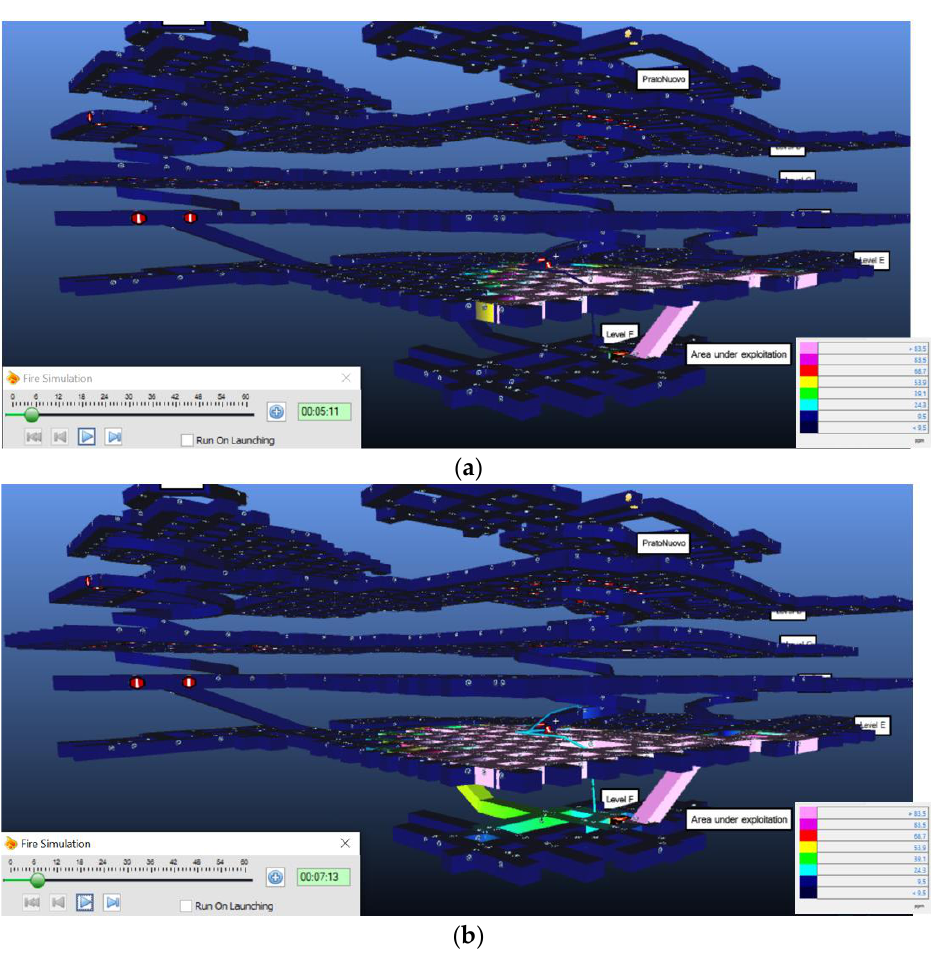
Figure 6. Concentration of carbon monoxide (CO) in ppm in the lower areas of the mine in the presence of a fire of a loader at Level F (Case B1). ( a ) After 5 min from the start of the fire and ( b ) after 7 min from the start of the fire. The colors correspond to the ranges of CO concentration values shown in the legend.